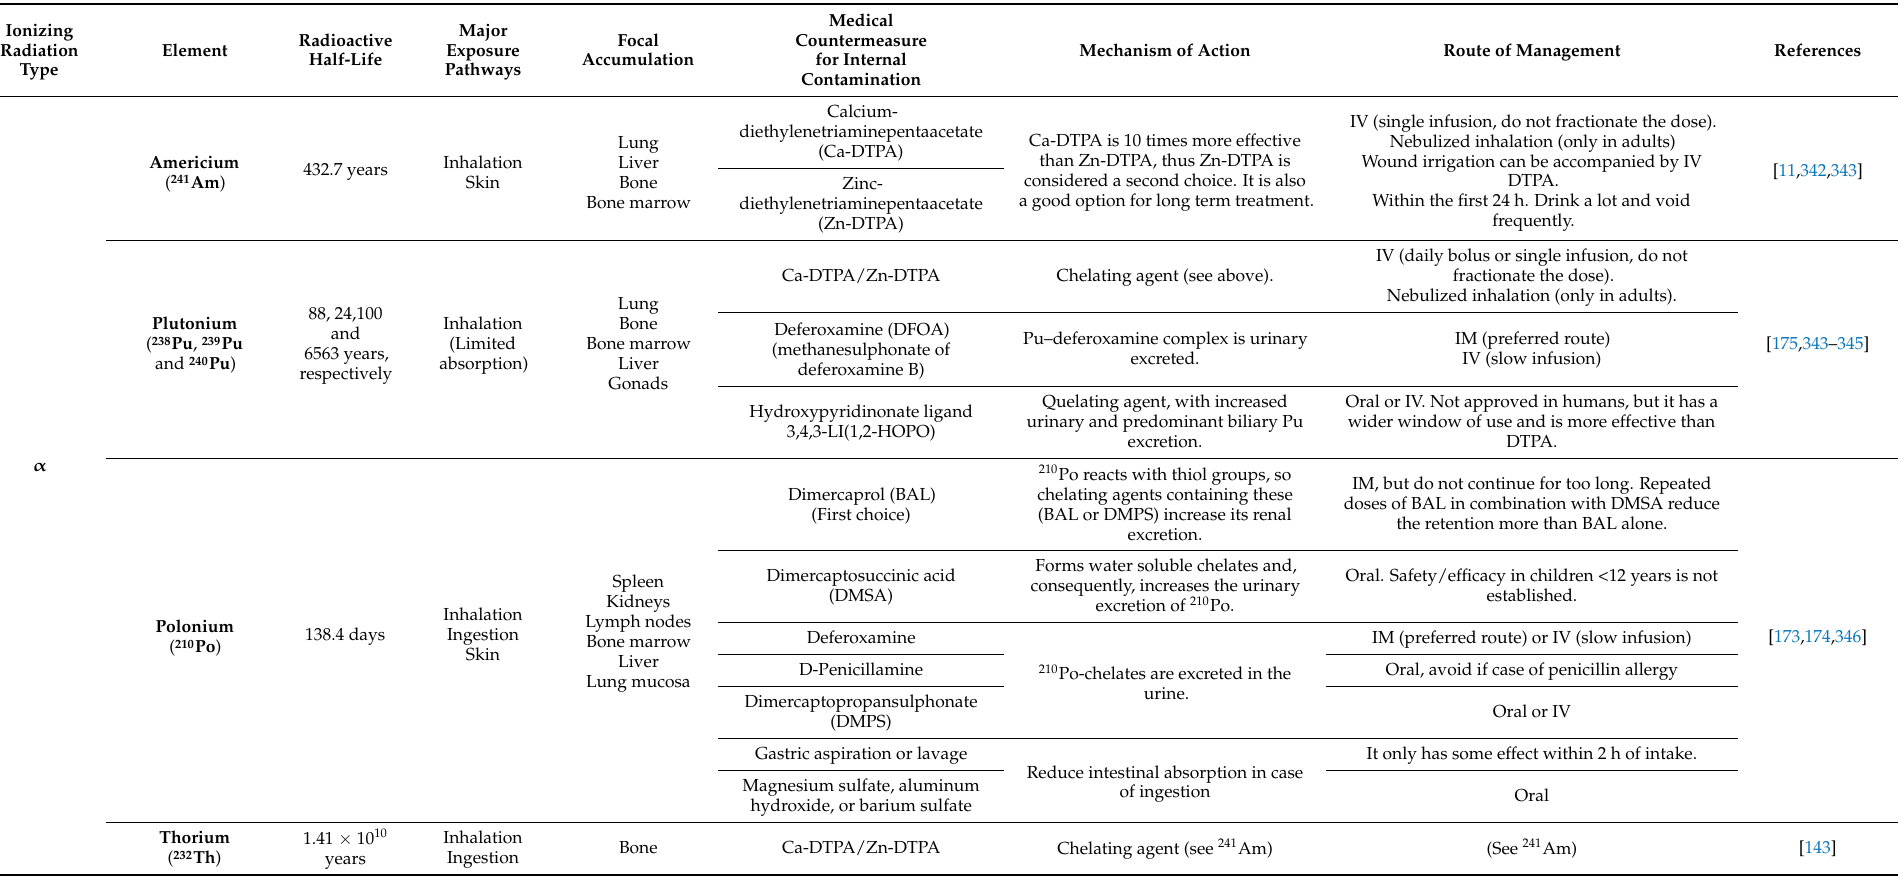
Table 1. Contamination by radionuclides and medical